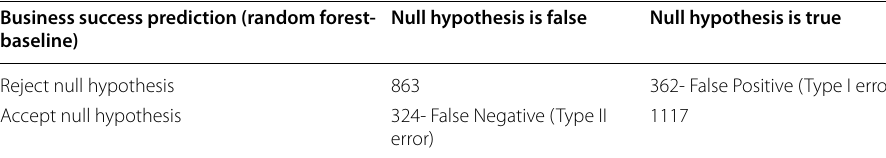
Table 7 Type I and Type II hypothesis testing error-baseline Business success prediction (random forest‑ baseline)